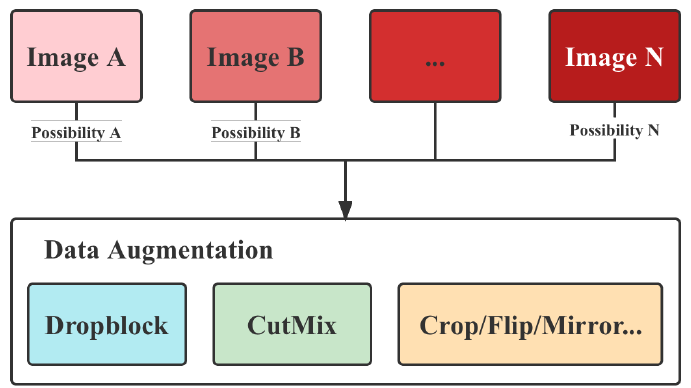
Figure 2. Illustration of the data augmentation